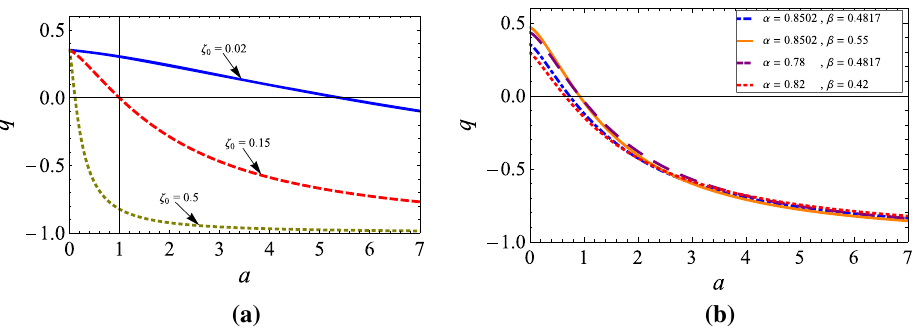
Fig. 2 a The variation of q with a for different values of ζ 0 with fixed ω d = − 0 . 5, α = 0 . 8502 and β = 0 . 4817. b The variation of q with a for different values of α and β with fixed ζ 0 = 0 . 2 and ω d = − 0 .